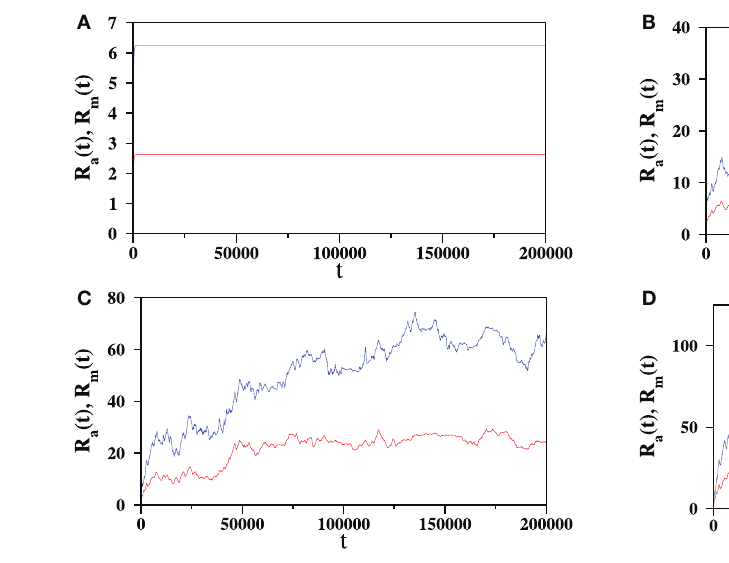
R a (red) have been shown with different strengths of the noise parameter: (A) η = 0, (B) 0.2, (C) 0.5, and (D) 1. The initial positions and velocities are same in all four